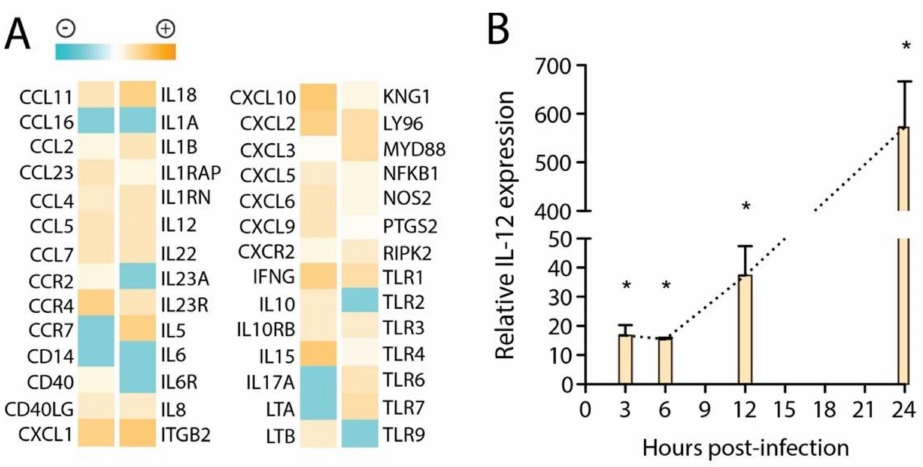
Figure 3. Th1-polararized transcriptional response by DENV-activated huMCs ( A ) The heat map depicts the relative expression levels of multiple genes assayed by real-time PCR array, with highest expression depicted as dark orange and lowest as dark blue. ( B ) IL-12 expression levels in huMCs, relative to untreated huMC control levels, measured by real-time PCR after DENV exposure at an MOI of 1. * indicates a significant increase over baseline levels by 1-way ANOVA ( p <